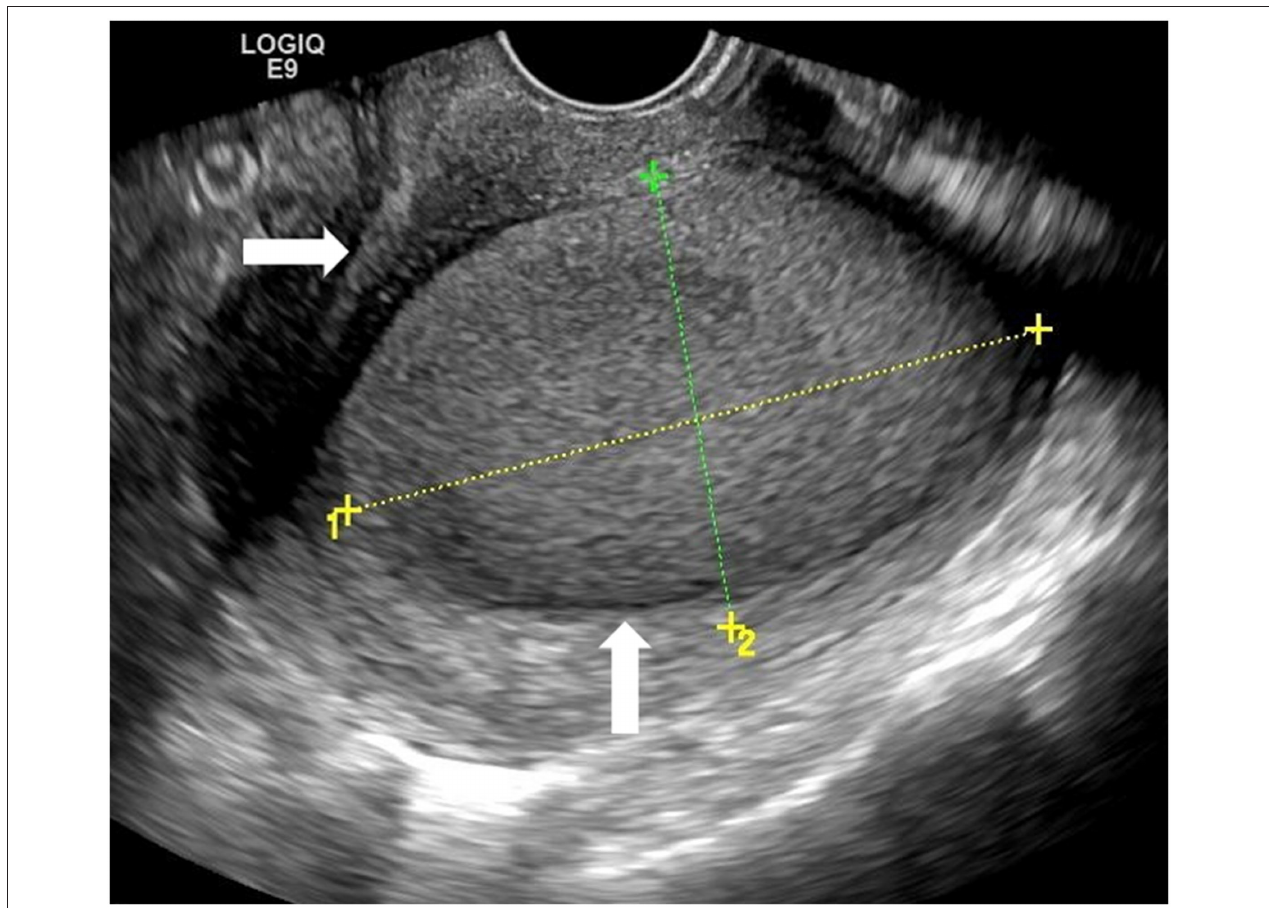
FIGURE 1 | Transvaginal ultrasound showed a cystic mass (vertical arrow) in the posterior myometrium, accompanied by dense echo spots. The uterine cavity (horizontal arrow) did not communicate with the